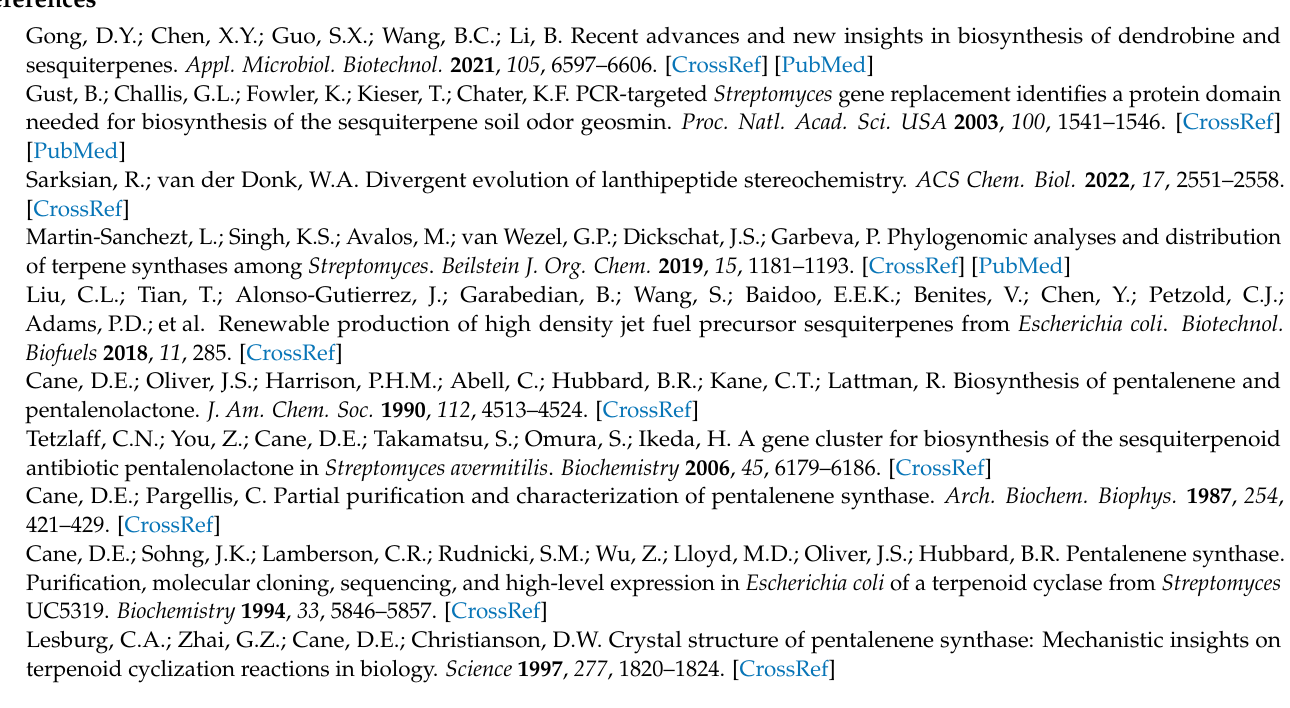
Table S2: The proportions of sesquiterpenes (%) produced by wild type and variants of PentS; Figure S1: Schematic diagram of the expression constructs containing genes encoding the biosynthesis pathway of pentalenene (reference [14,45] is cited in supplementary materials); Figure S2: Mass spectra of main products produced by wild type and variants of PentS; Figure S3: Protein expression and solubility analysis of wild type and variants of PentS; Figure S4: Comparisons of peak patterns of T182 mutants; Figure S5: Multiple-sequence alignment of PentS (WP_186284259.1) with natural variants of pentalenene synthase; Figure S6: Binding pattern comparisons of PentS–FPP